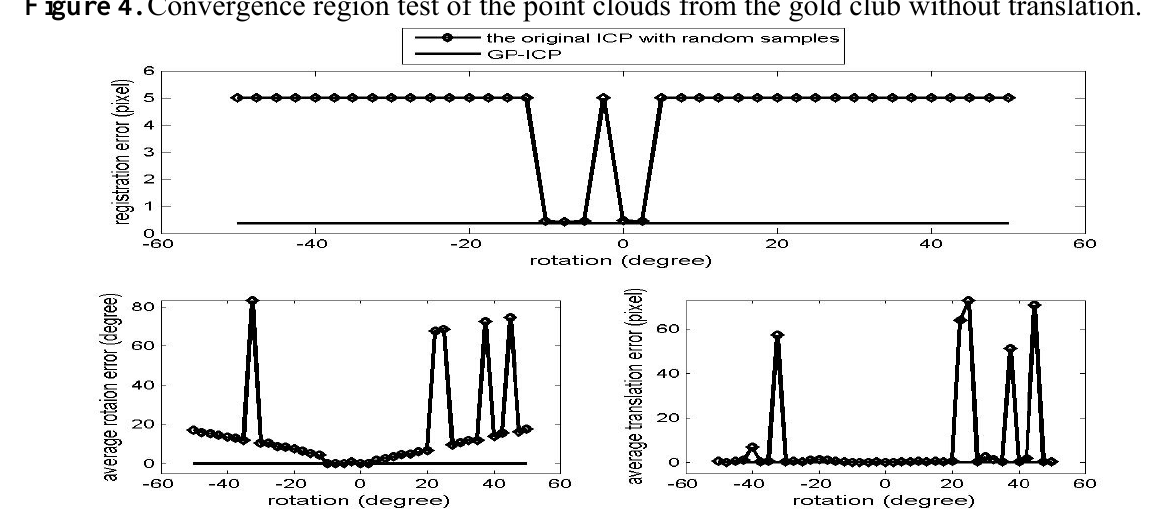
Figure 4. Convergence region test of the point clouds from the gold club without translation.